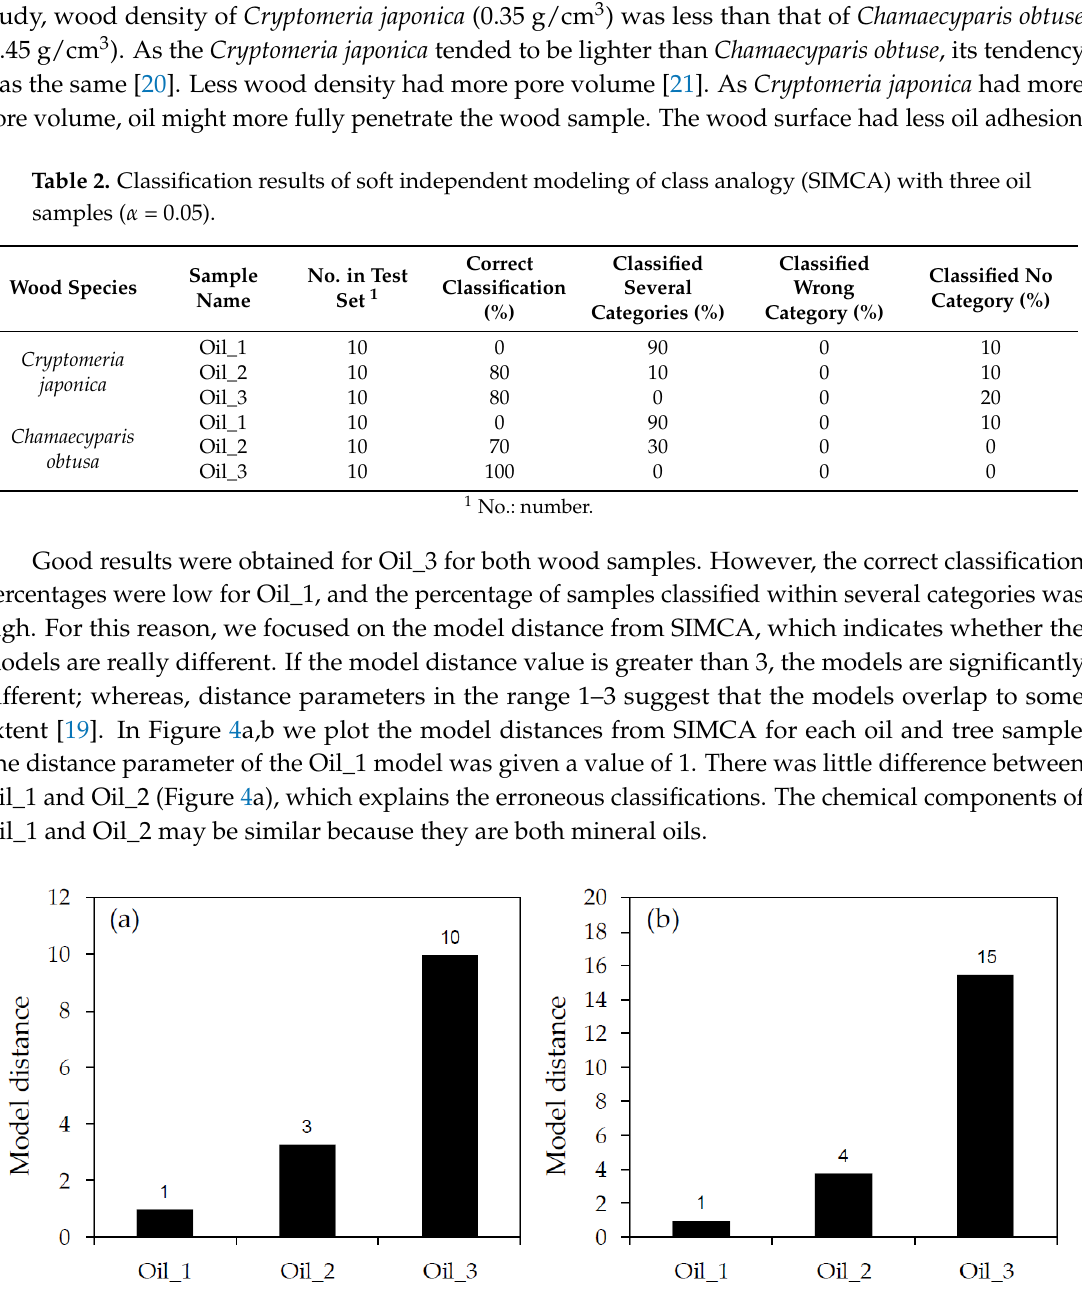
Figure 4. Model distance plot for the three oils on the wood samples: ( a ) Cryptomeria japonica ; ( b ) Chamaecyparis obtusa .